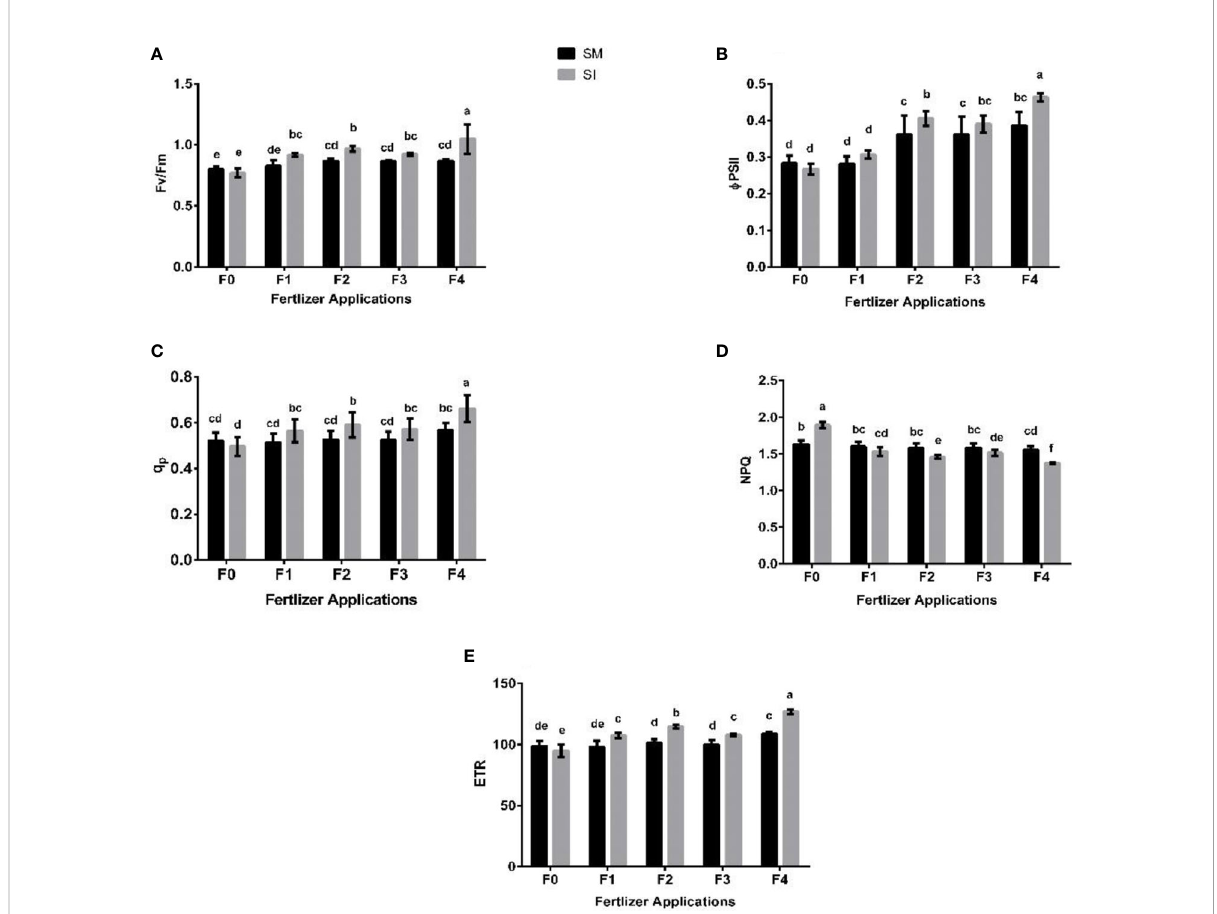
FIGURE 4 Leaf chlorophyll fl uorescence parameters such as Fv/Fm; maximum fl uorescence (A) , f PSII; ef fi ciency of the photosystem (B) , qp; photochemical quenching (C) , NPQ; non-photochemical quenching (D) , ETR; electron transport rate (E) of soybean crop under different planting patterns such as SM; soybean mono-cropping, SI; soybean intercropping and fertilizer application treatments such as F0 ; without fertilizer application, F1 ; nitrogen fertilizer application, F2 ; nitrogen fertilizer with foliar application of iron, F3 ; nitrogen fertilizer with foliar application of molybdenum, F4 ; nitrogen fertilizer with foliar application of iron and molybdenum. The column bars with dissimilar lowercase letters are signi fi cantly different from each other as per the LSD test (p<